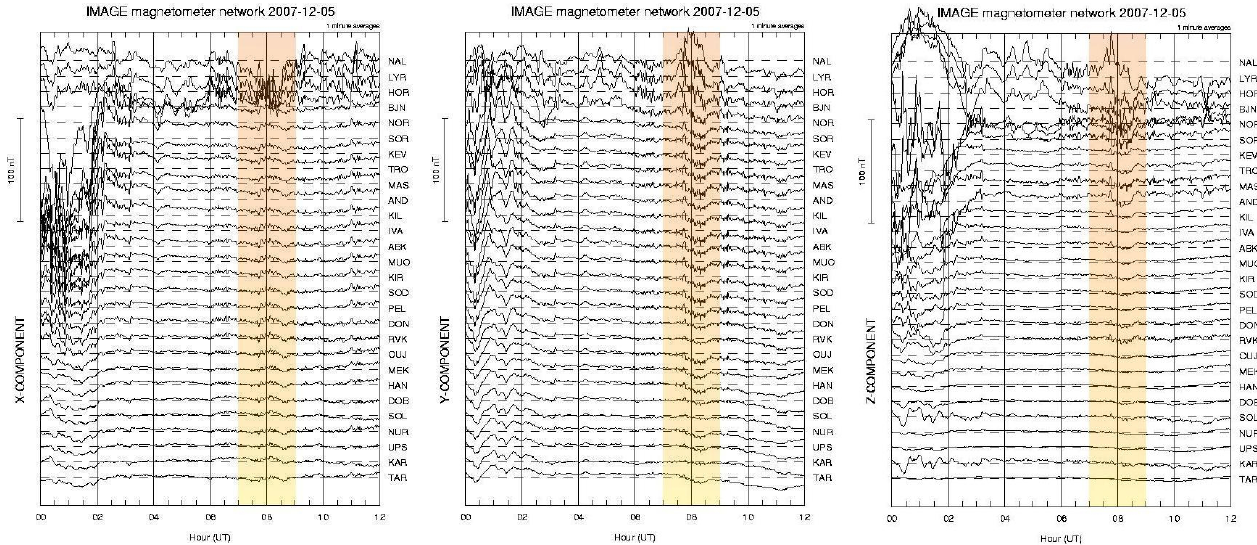
Fig. 2. IMAGE magnetometer chain data for the period 00:00–12:00UT on 5th December 2007 seperated into (a) X-component, (b) Y- Figure 2: IMAGE magnetometer chain data for the period 0000-1200 UT on 5th December component and (c) Z-component. In each subplot the period from 07:00–09:00UT is 2007 seperated into (a) X-component, (b) Y-component and (c) Z-component. In each subplot the period from 0700-0900 UT is highlighted.